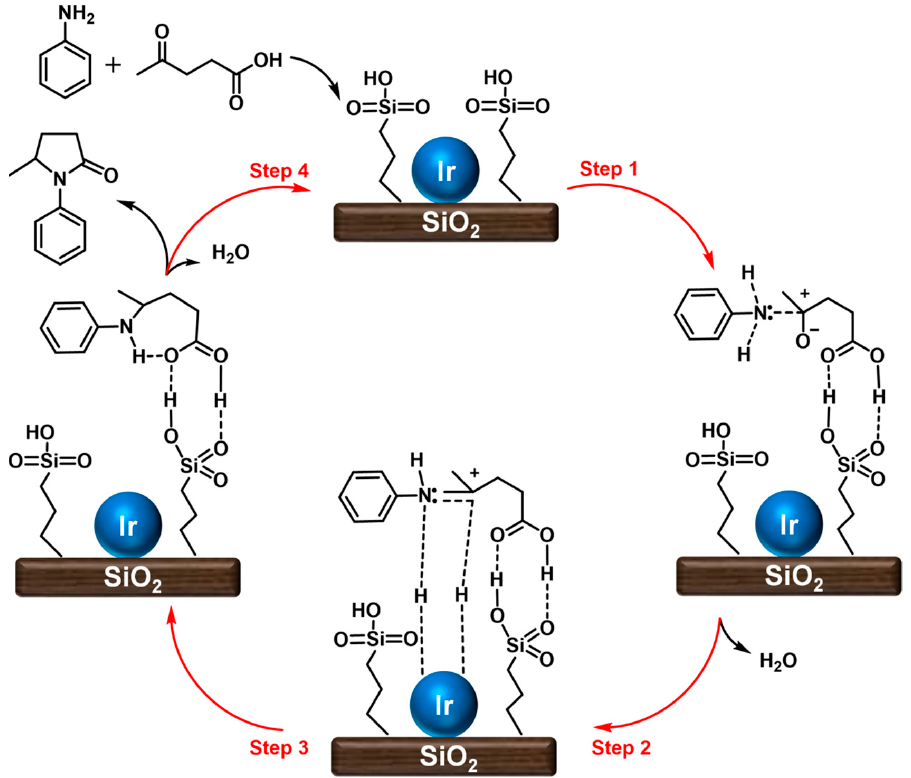
Scheme 4. Plausible mechanism for the reductive amination of LA with aniline over an Ir/SiO 2 -SO 3 H catalyst. Adapted with permission from ref. [101]. Copyright 2017 Elsevier.